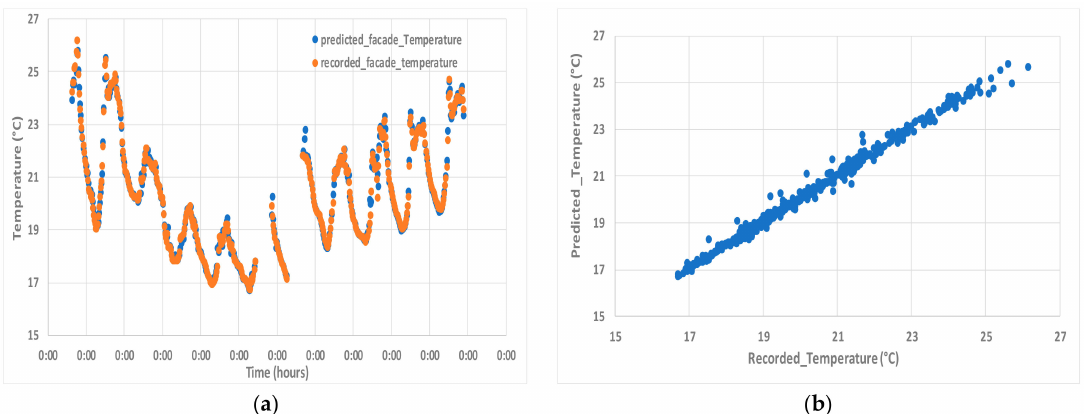
Figure 3. Predicted and recorded facade temperatures: ( a ) variation of both temperatures in time domain; and ( b ) the predicted facade temperature with the recorded facade temperature.